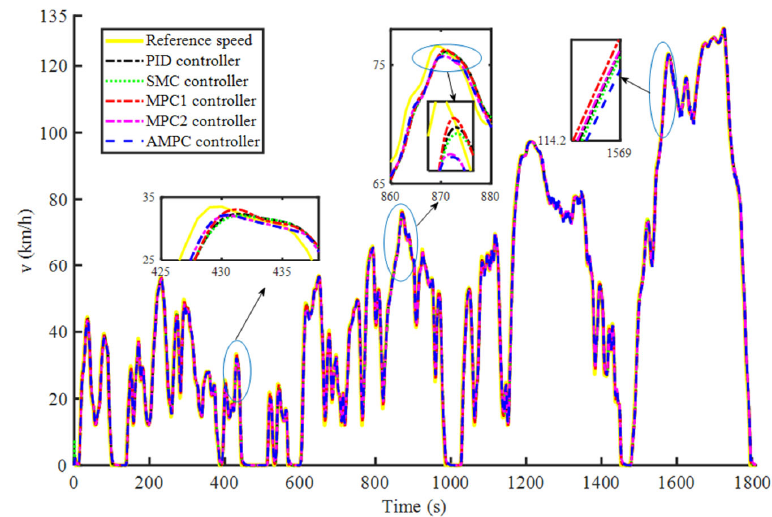
Figure 11. Speed tracking curve of each controller.